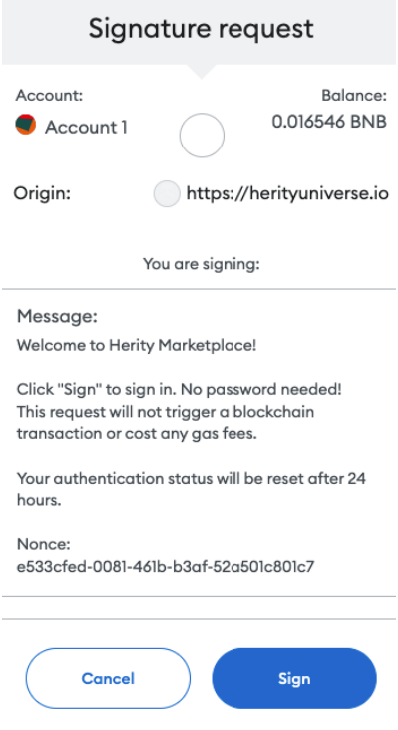
Figure 4. Wallet login using